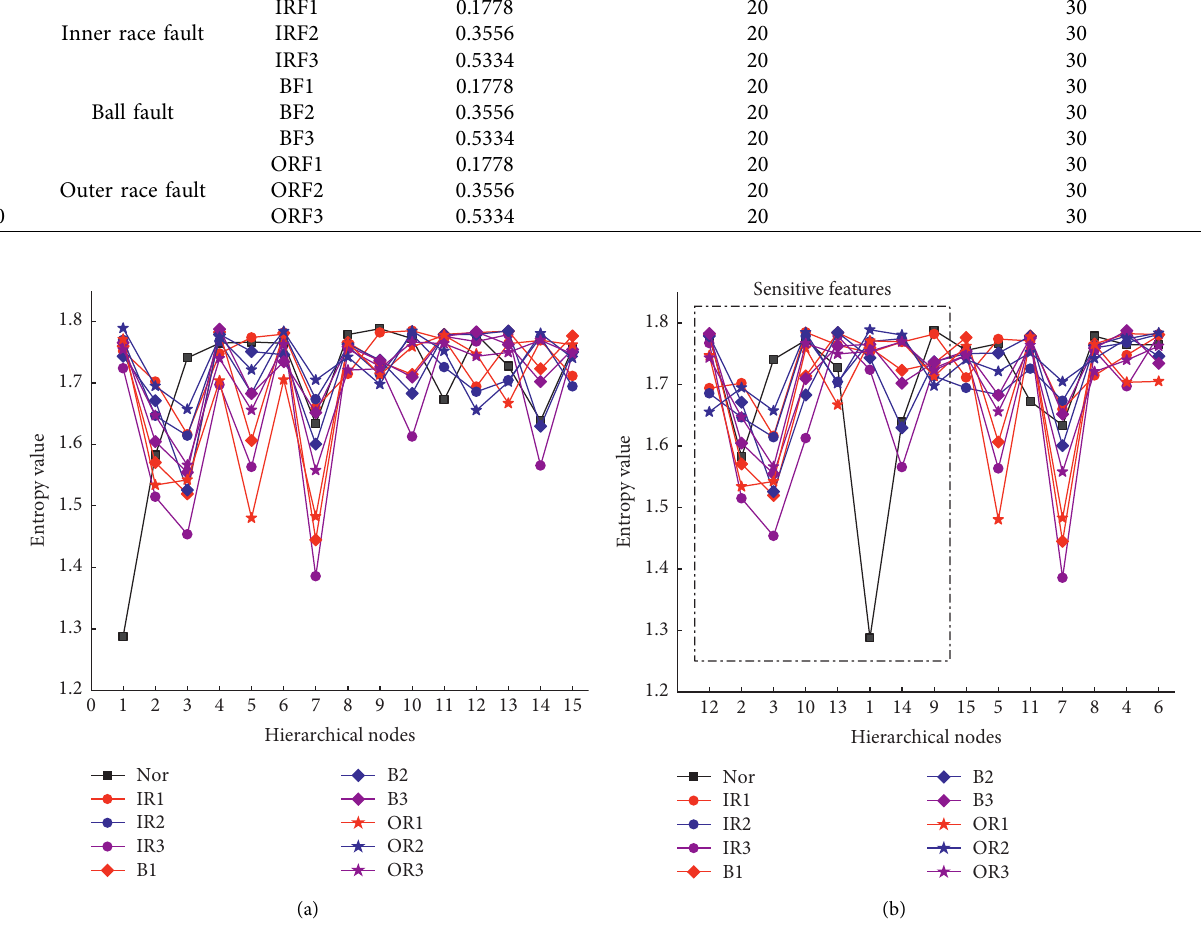
Figure 7: The original feature vectors and the sensitive feature vectors. (a) Original fault features; (b) fault features after ranking.